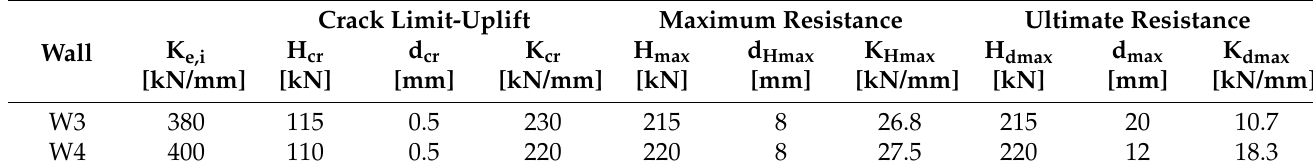
Table 9. Resistance and deformability parameters for jacketed walls W3 and W4 ( σ v = 0.8 N/mm 2 ).